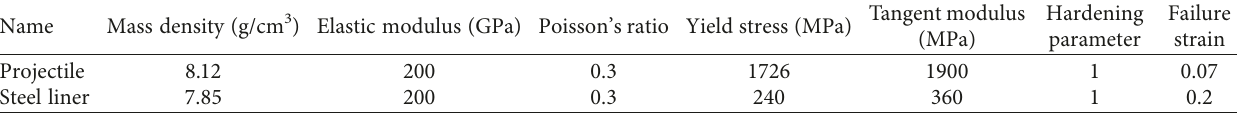
Figure 7: (a) Geometry size and (b) finite element model of projectile and target (3-0). Table 1: Material model parameters of the projectile and steel liner.